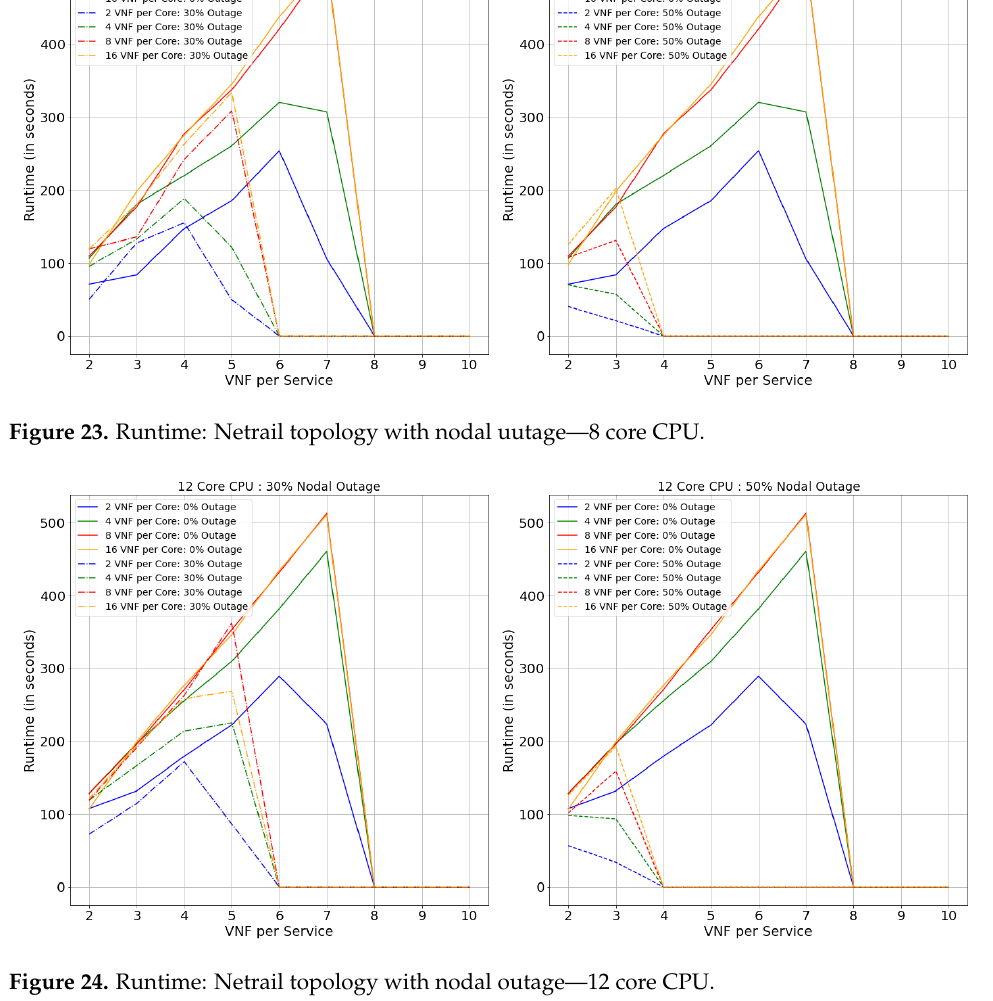
Figure 24. Runtime: Netrail topology with nodal outage—12 core